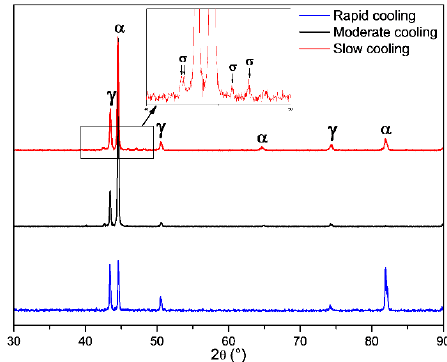
Figure 2. XRD spectra of 2205 DSS cooled rapidly, moderately and slowly.